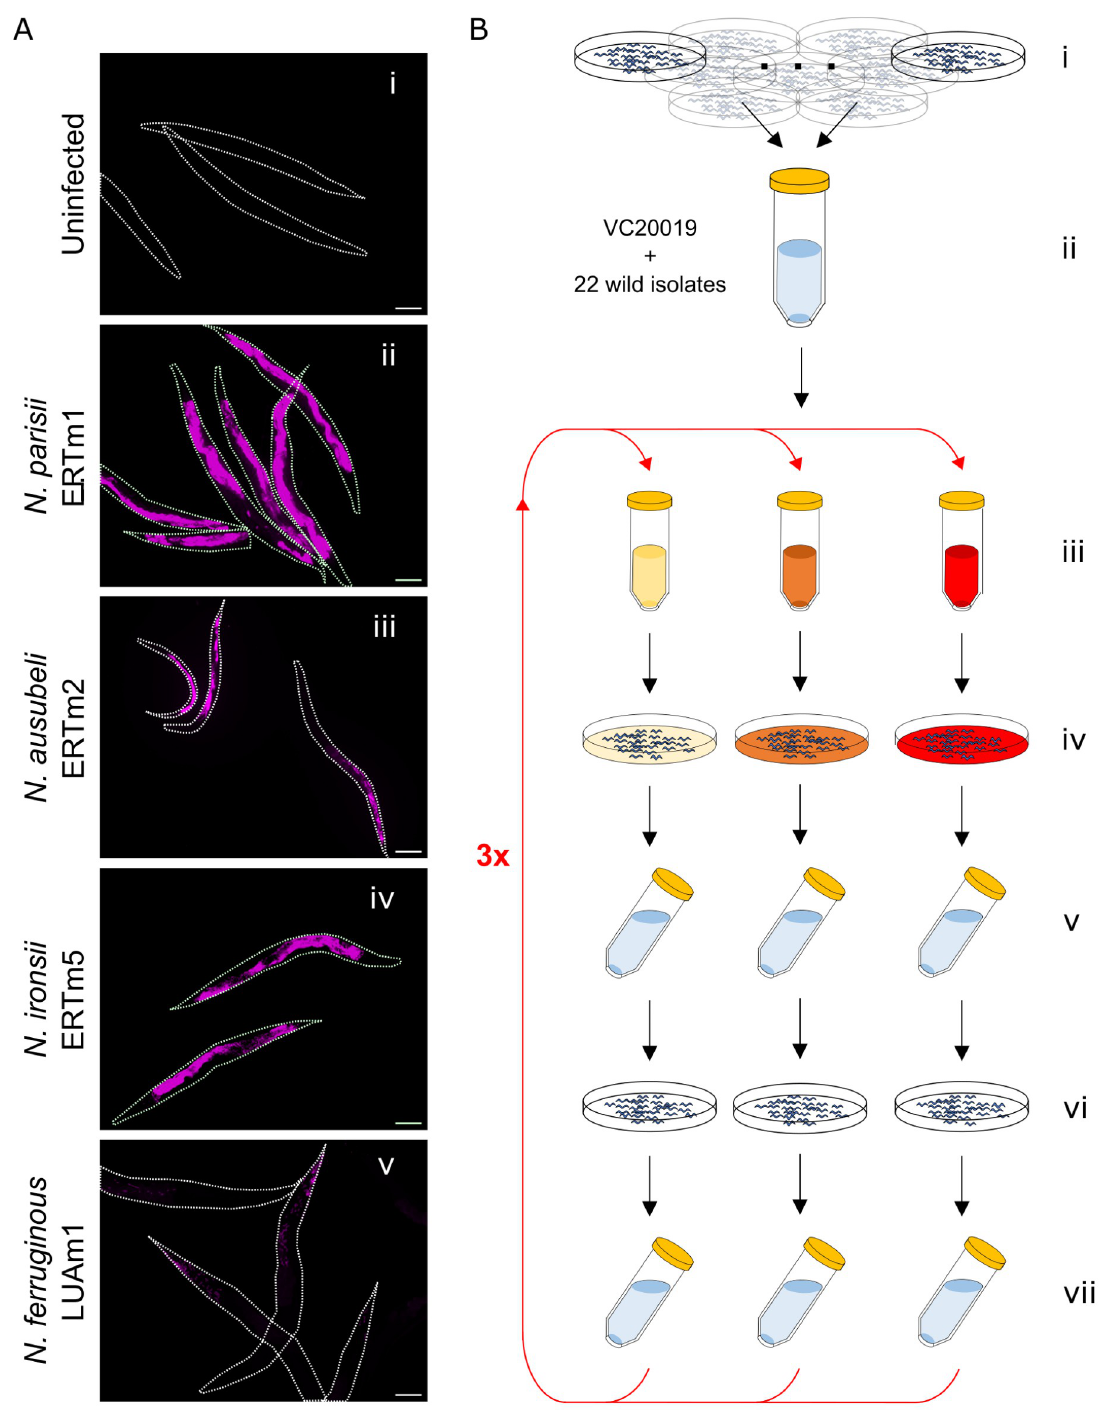
Fig 1. A PhenoMIP high-throughput screen to identify wild strains that are either resistant or susceptible to microsporidia infection. (A) N2 L1 animals that were uninfected (i) or exposed to either 3.5 million N . parisii , N . ironsii , or N . ausubeli spores or 1.25 million N . ferruginous spores for 72 hours, were fixed and stained with the following 18S FISH probes (i, ii, iv; MicroB-CAL Fluor Red 610, iii; Microsp1A-FAM and v; a combination of three Fluor Red 610 probes described in the Methods). Scale bars, 100 μ m. (B) PhenoMIP screening protocol for microsporidia requires that separate unstarved populations for each of the 22 wild isolate strains as well as VC20019 (lab reference-derived strain) be sodium hyplochlorite-synchronized (i) before pooling in equimolar amounts (ii) and infecting (iii) with